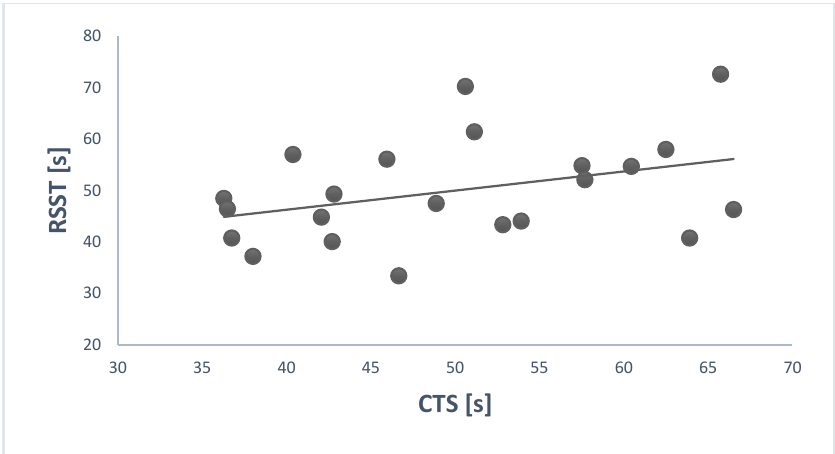
Figure 5. Correlation between the total times taken in the CST and the RSST.